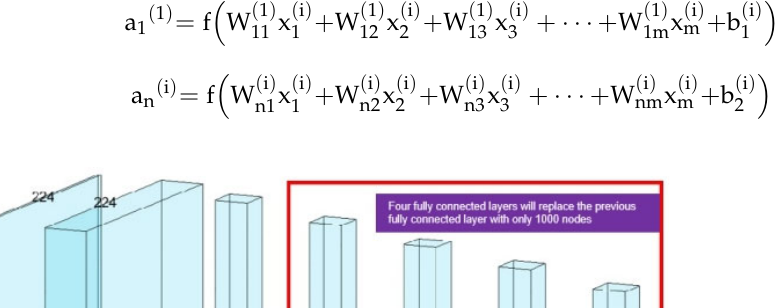
Figure 7. Multi ‐ machine learning model architecture.